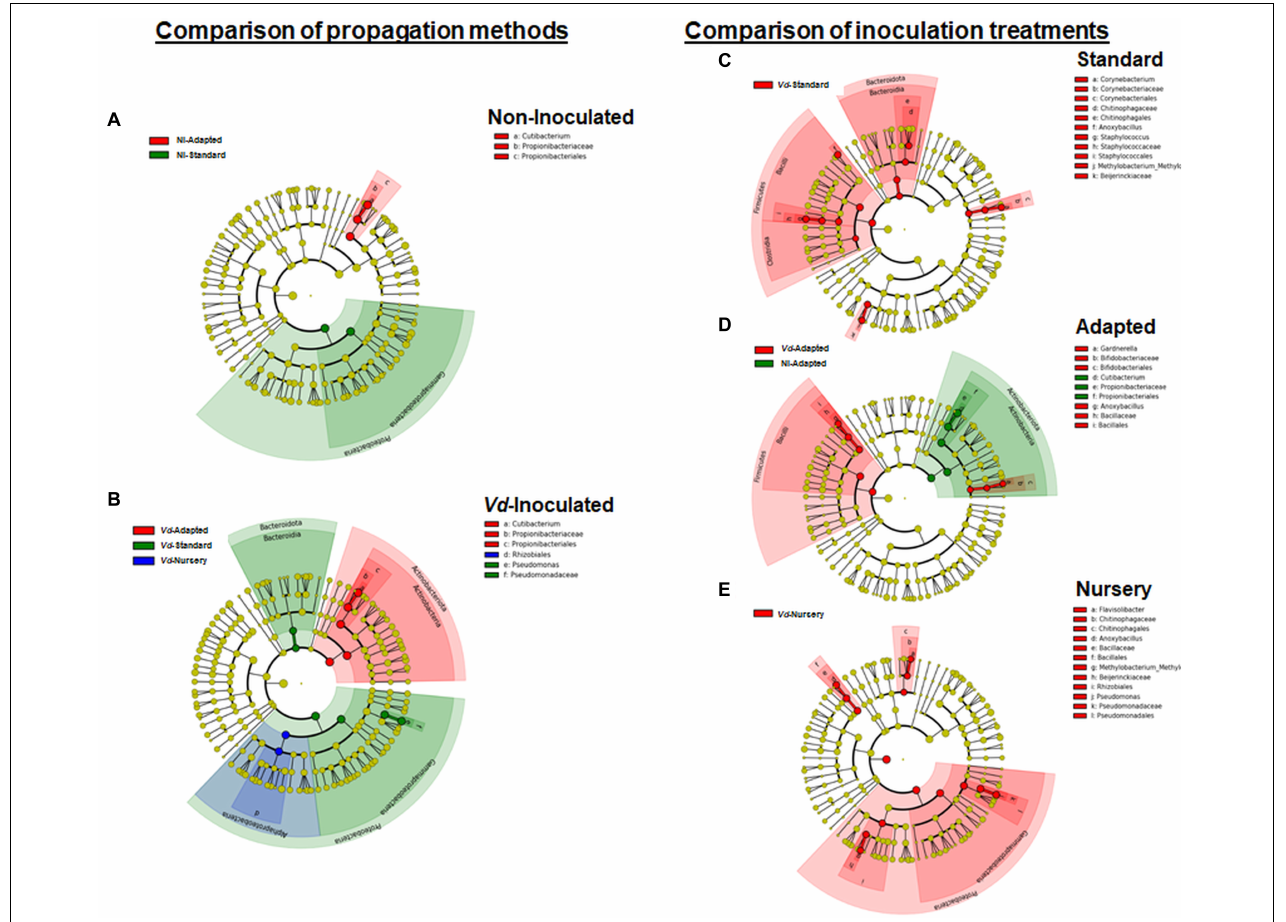
FIGURE 6 | Cladogram representation from LEfSe analysis showing the taxonomic ranks from the innermost phylum ring to the outermost genera ring. Each point is a member within each taxonomic rank. Significant taxa ( P < 0.05) appearing as dominant for each treatment when comparing each propagation method by inoculation treatment (A,B) , or each inoculation treatment by propagation method (C–E) are shown in different colors (red, green, or blue) associated to the legend of each individual